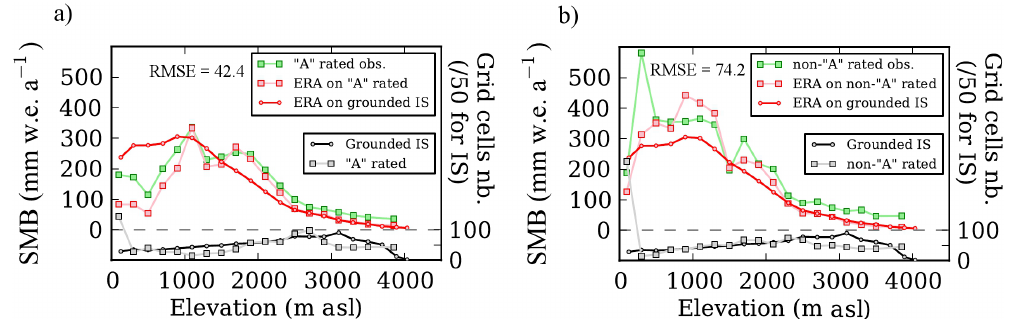
Fig. 7. Mean SMB over the grounded ice sheet as a function of elevation a) for “A” rated data and b) for non “A” rated data. Pink squares are the mean SMB calculated by ERA-Interim for grid cells containing observations within each elevation range. Red circles are mean SMB calculated by ERA-Interim over each entire range of elevations. Green squares are mean observed SMB from grid cells containing observations within each elevation range. The gray line represents the contribution of areas with observation to the grounded ice sheet area (for each elevation range). The red line represents the contribution of entire elevation range to the grounded ice sheet. Each elevation range is 200m. RMSE is computed between observations and ERA-Interim for grid cells containing observations by elevation